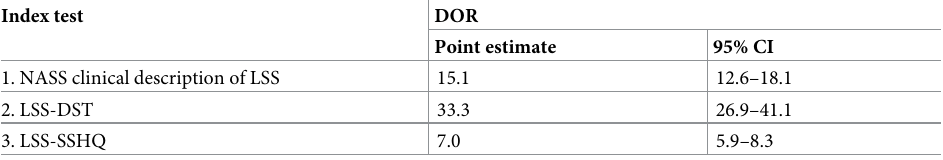
Table 6. DORs of the NASS clinical description of LSS, the LSS-DST, and the